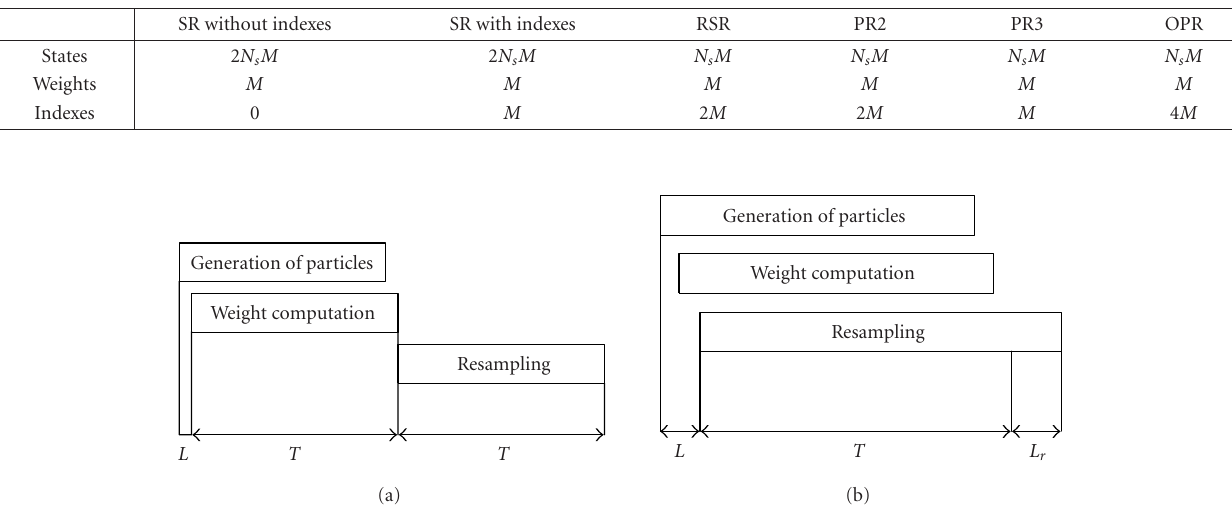
Table 3: Memory capacity for di ff erent resampling algorithms.